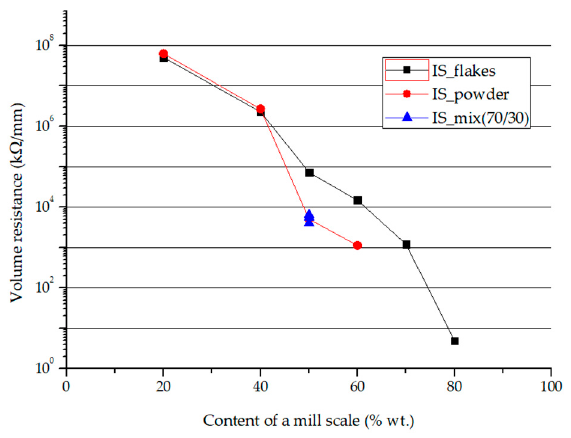
Figure 9. Volume resistance values.